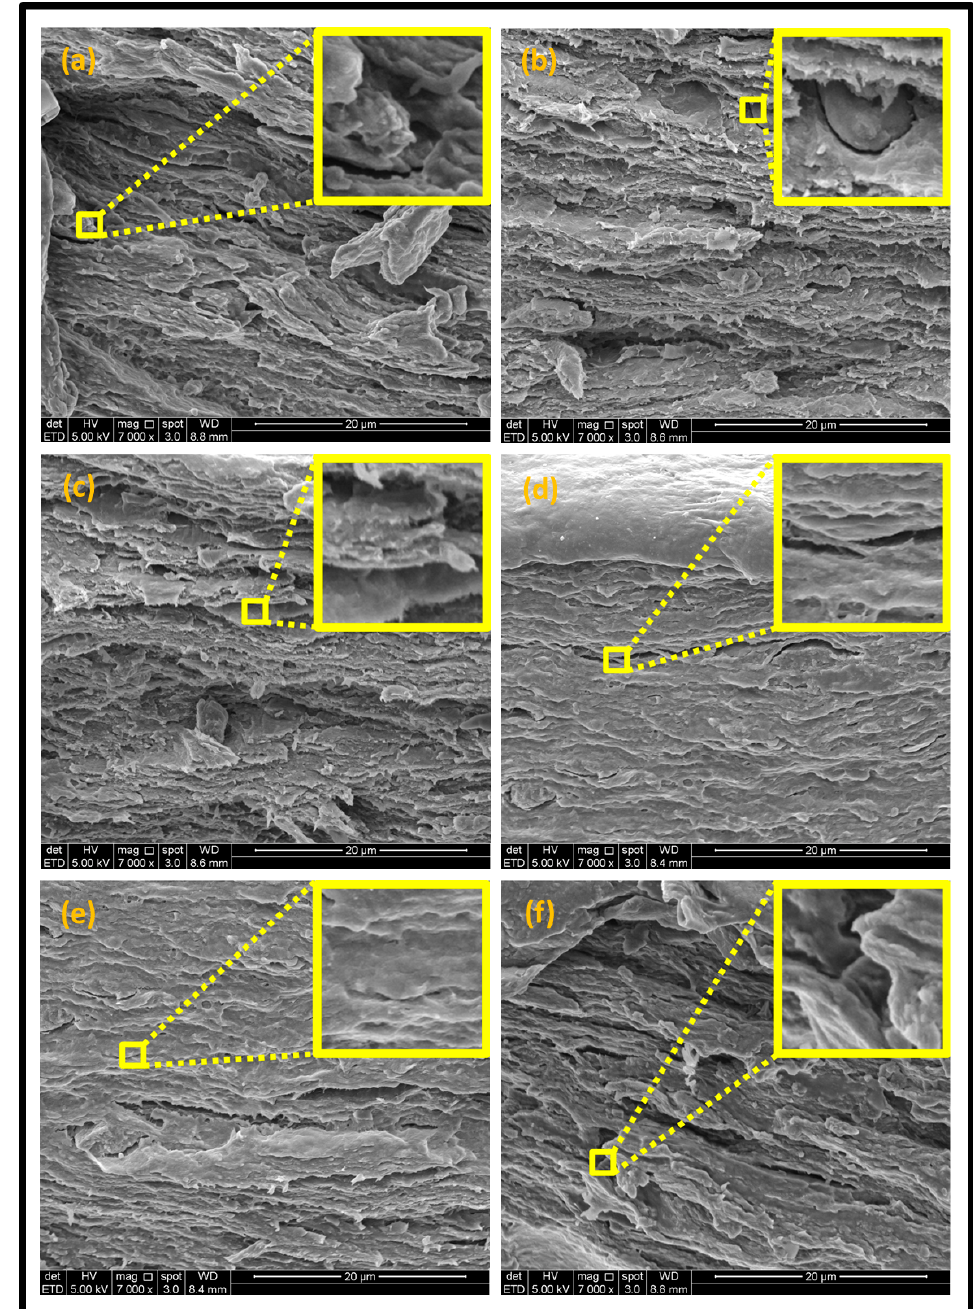
Figure 4. The fracture surface morphologies by Scanning Electron Microscope (SEM) of ( a ) seaweed film (control); ( b ) seaweed–neem film; ( c ) irradiated seaweed–neem at 0.5 kGy; ( d ) irradiated seaweed–neem at 1 kGy; ( e ) irradiated seaweed–neem at 1.5 kGy; ( f ) irradiated seaweed–neem at 2 kGy. Thermal properties of the seaweed based films were studied using Thermogravimetric analysis (TGA) to investigate the decomposition and thermal stability of the films (Figure 5). It was revealed that the initial temperature of degradation (T on ), which is the point, the film began to disintegrate where deflection on the TGA curve was observed. The maximum temperature of degradation (T max ) of the seaweed film was